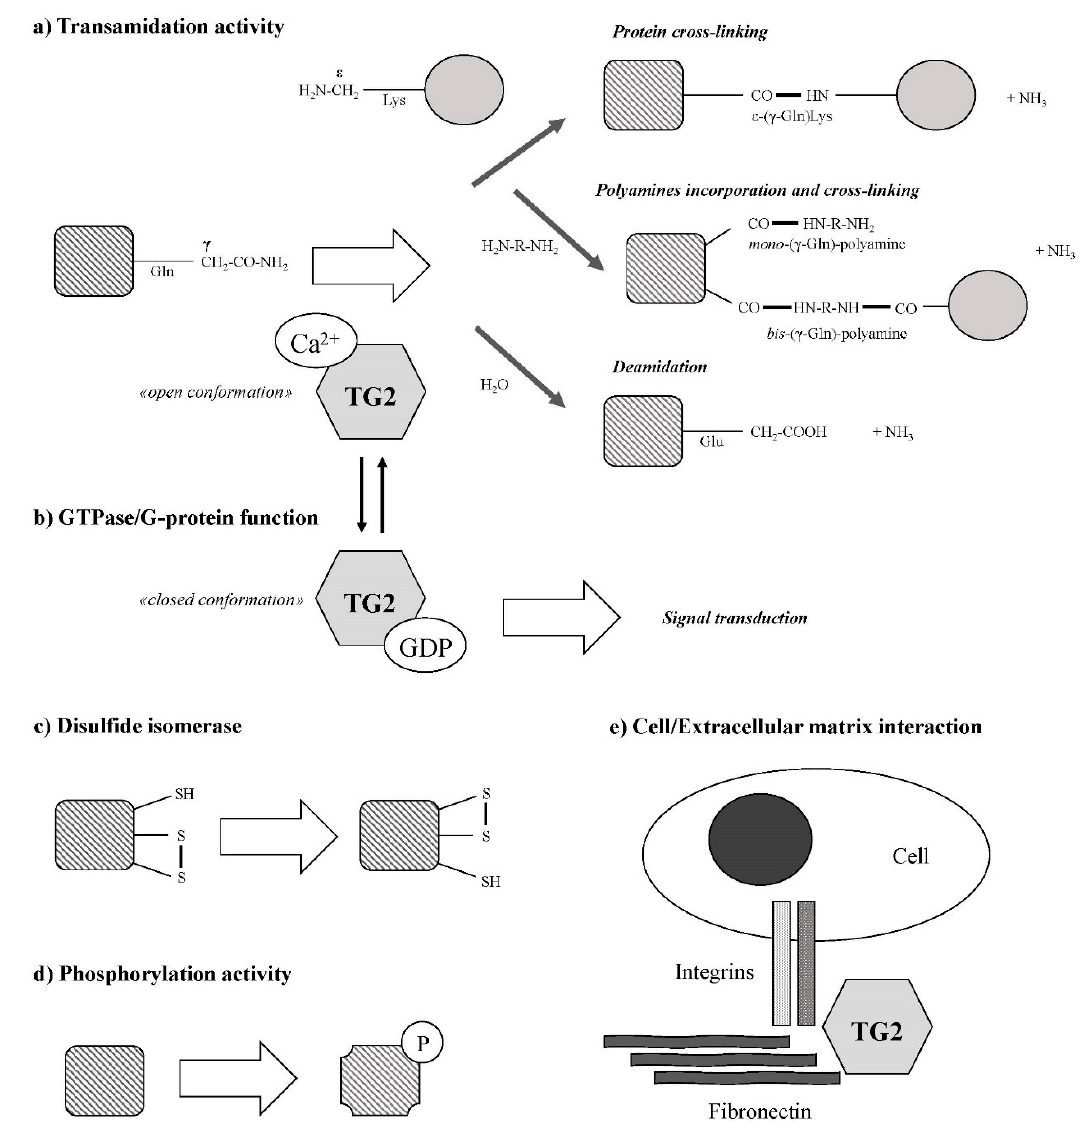
Figure 1. Reactions catalyzed by type II transglutaminase or tissue transglutaminase (TG2) (from Tatsukawa et al. [62] with modifications).